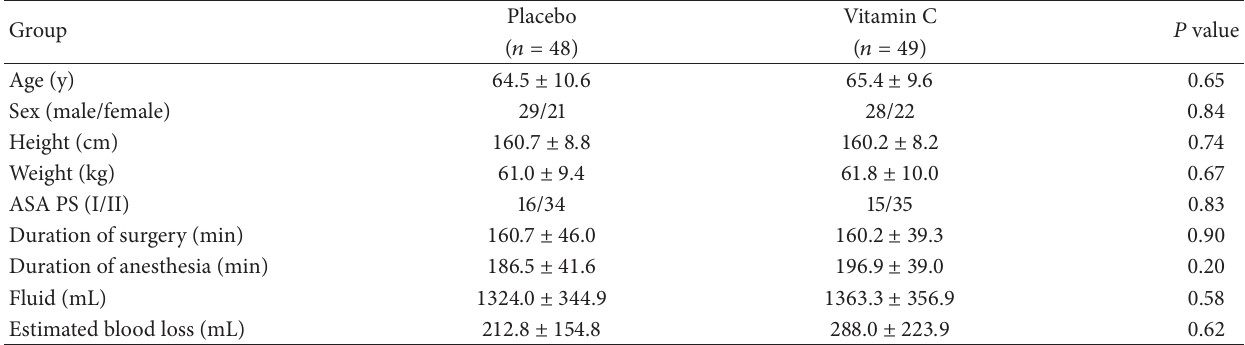
Table 1: Patient characteristics and perioperative data.